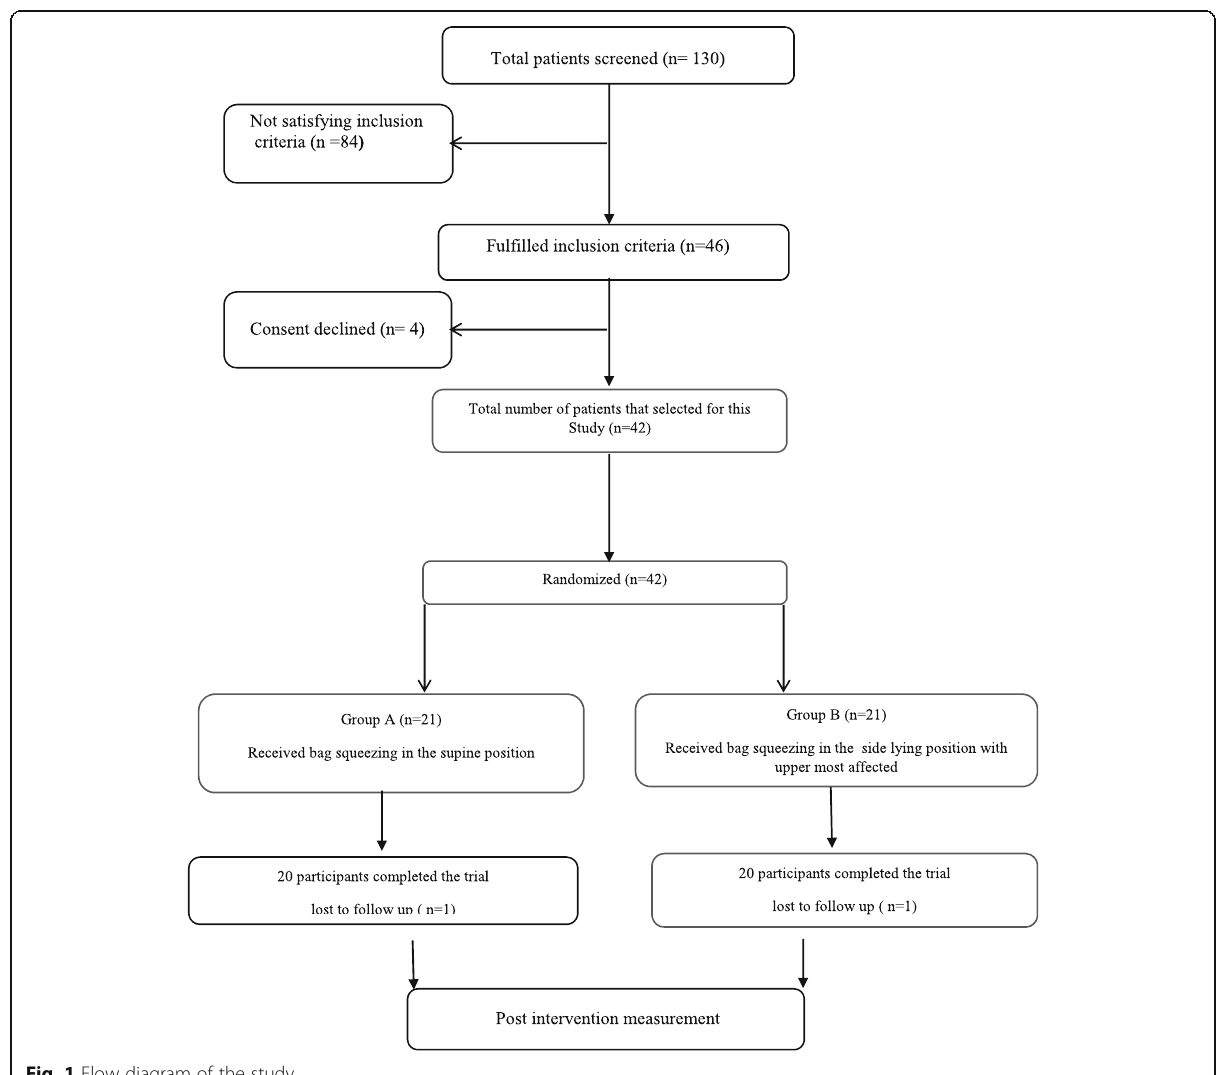
Fig. 1 Flow diagram of the